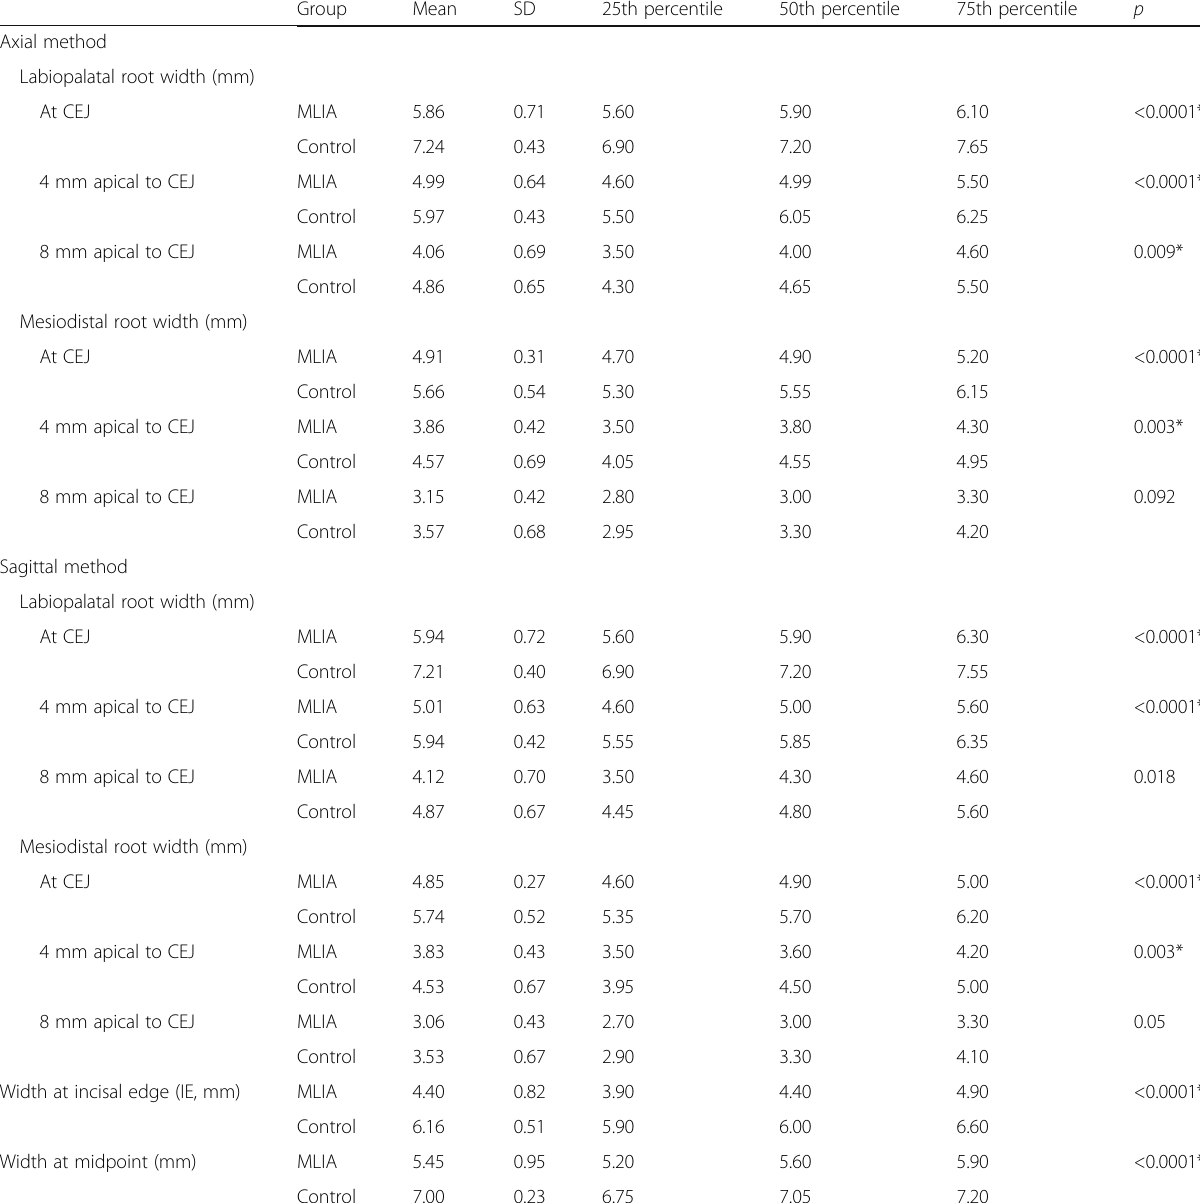
Table 3 Lateral incisor measurements from axial and sagittal sections Group Mean SD 25th percentile 50th percentile 75th percentile p